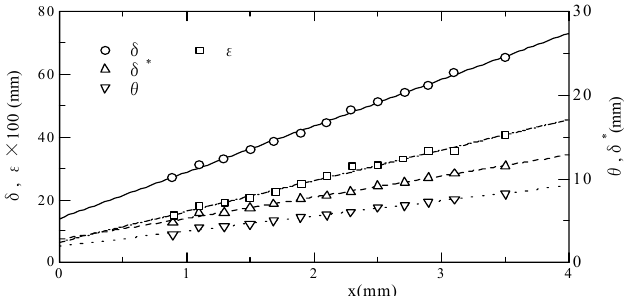
Fig.4 Development of length scales: boundary layer thickness δ , displacement thickness δ *, momentum thickness θ , and error-in origin ε